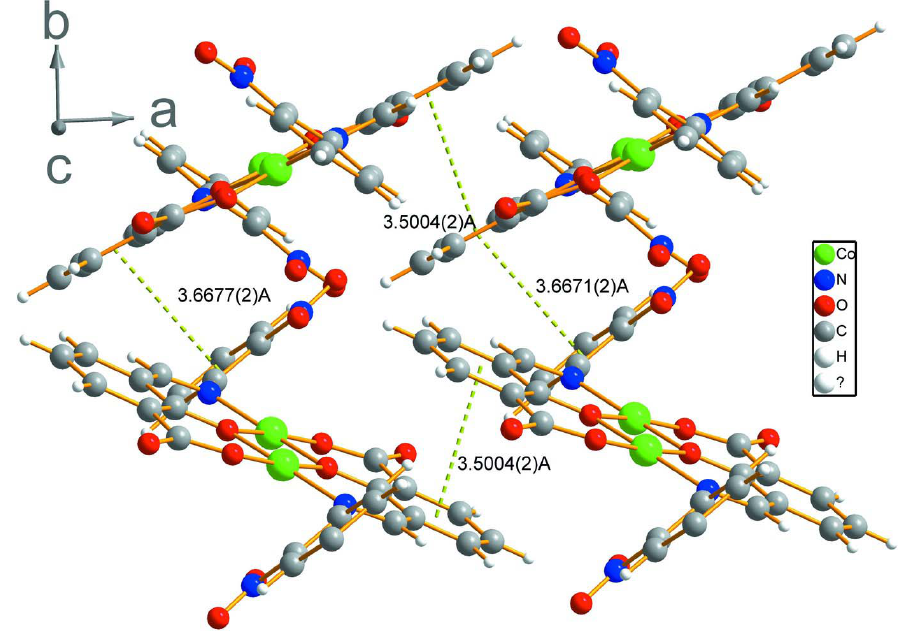
Figure 3 A view down the c axis of the π — π stacking interactions between the two-dimensional networks in compound